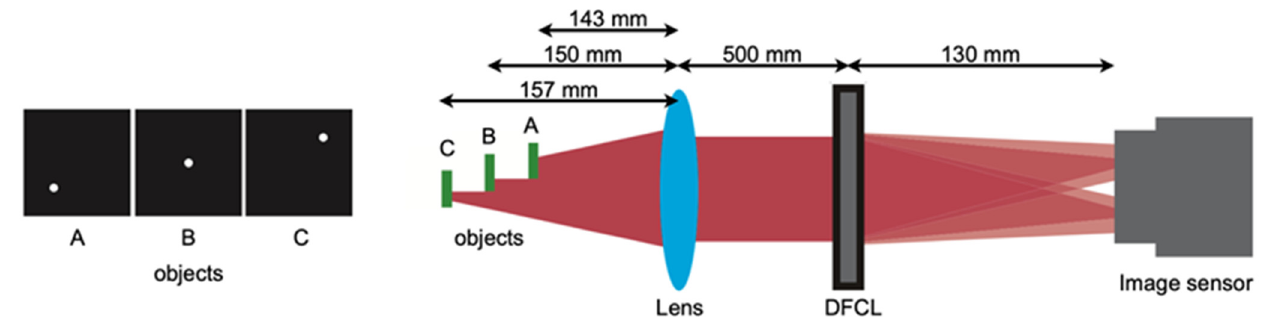
Figure 5. An assumed optical setup for numerical simulations.